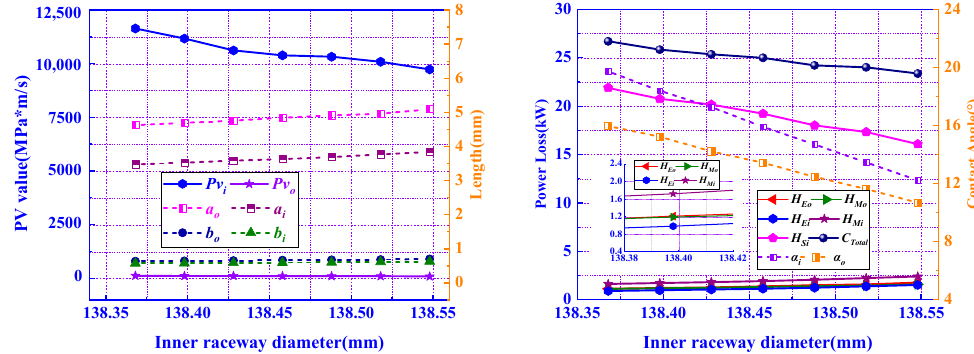
Figure 15. Influence of inner raceway diameter d i on power loss. Inner raceway curvature radius coefficients in the range of 0.535 to 0.547 were studied, Figure 16. It can be concluded that with the increase in